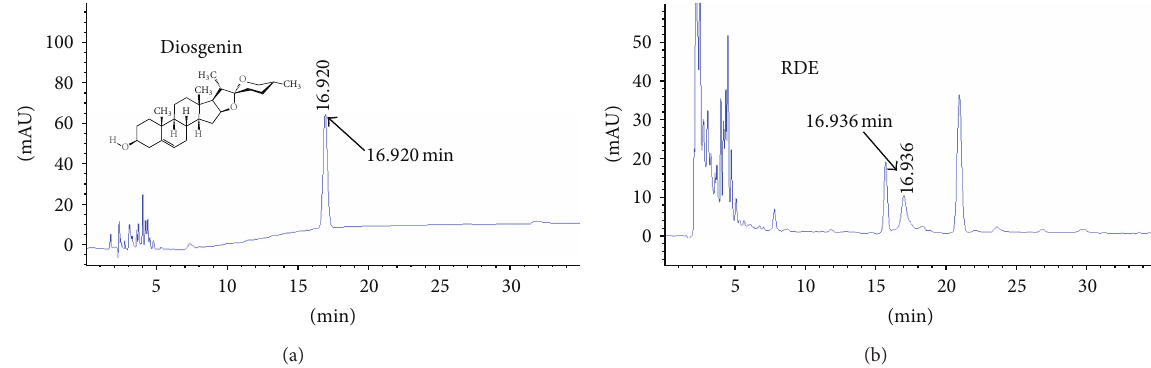
Figure 2: HPLC for the qualitative analysis of diosgenin in the RDE. The chromatograms for standard substances and RDE are shown in (a) and (b), respectively. ((a) and (b)) The chromatograms for standard substances of diosgenin and RDE,